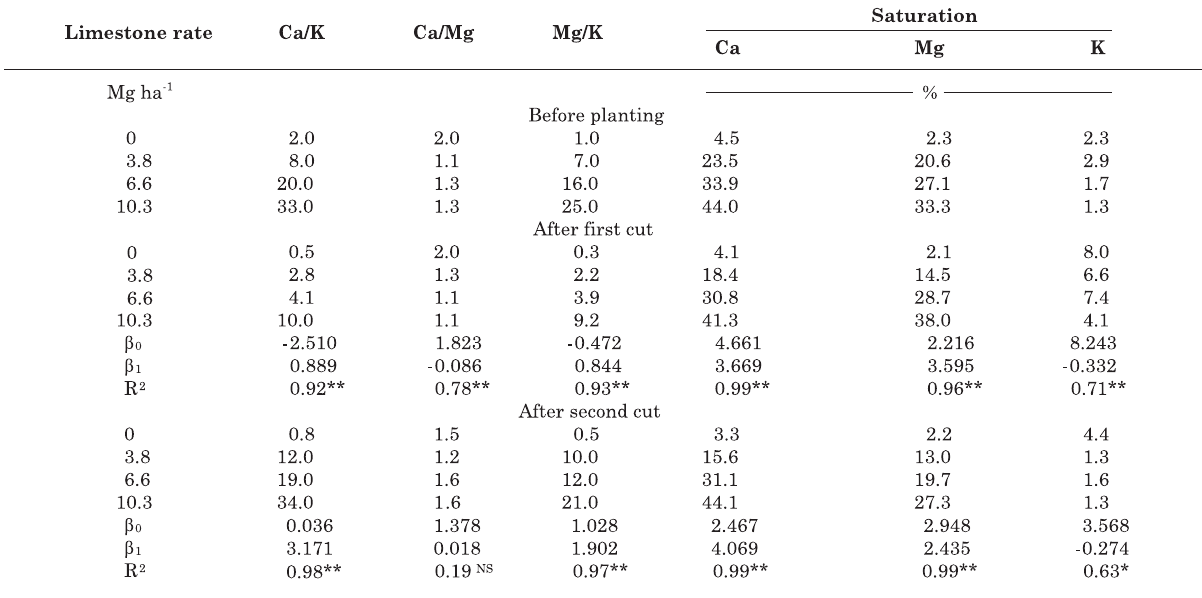
*, **, NS : significant at 5 and 1 % and non significant, respectively.